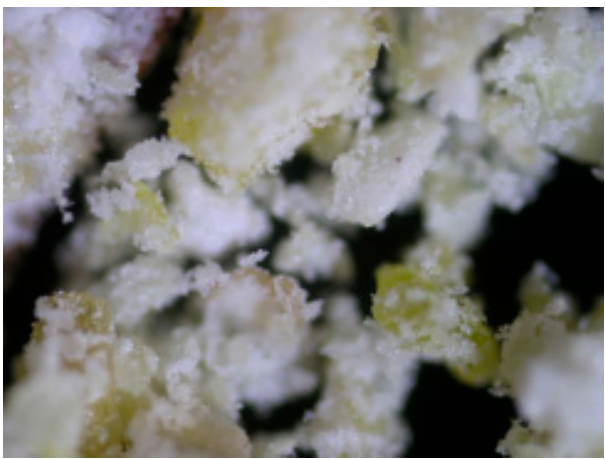
Figure 9. Structure of raw untreated corn bran.